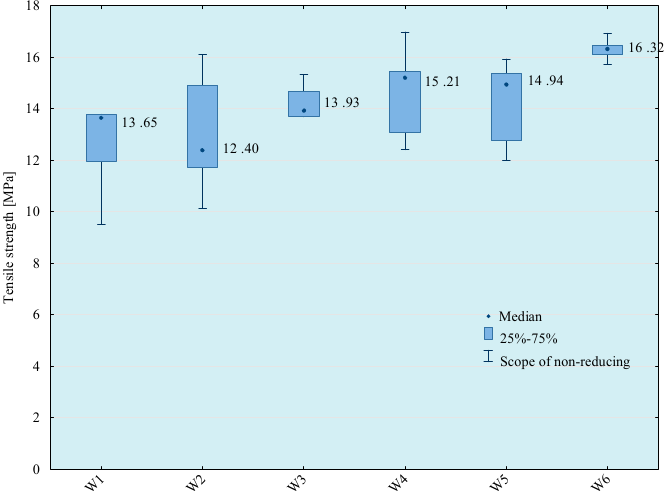
Figure 4. Tensile strength of E57/Z-1/ZR2/100:10:5 composition depending on the mixing method.